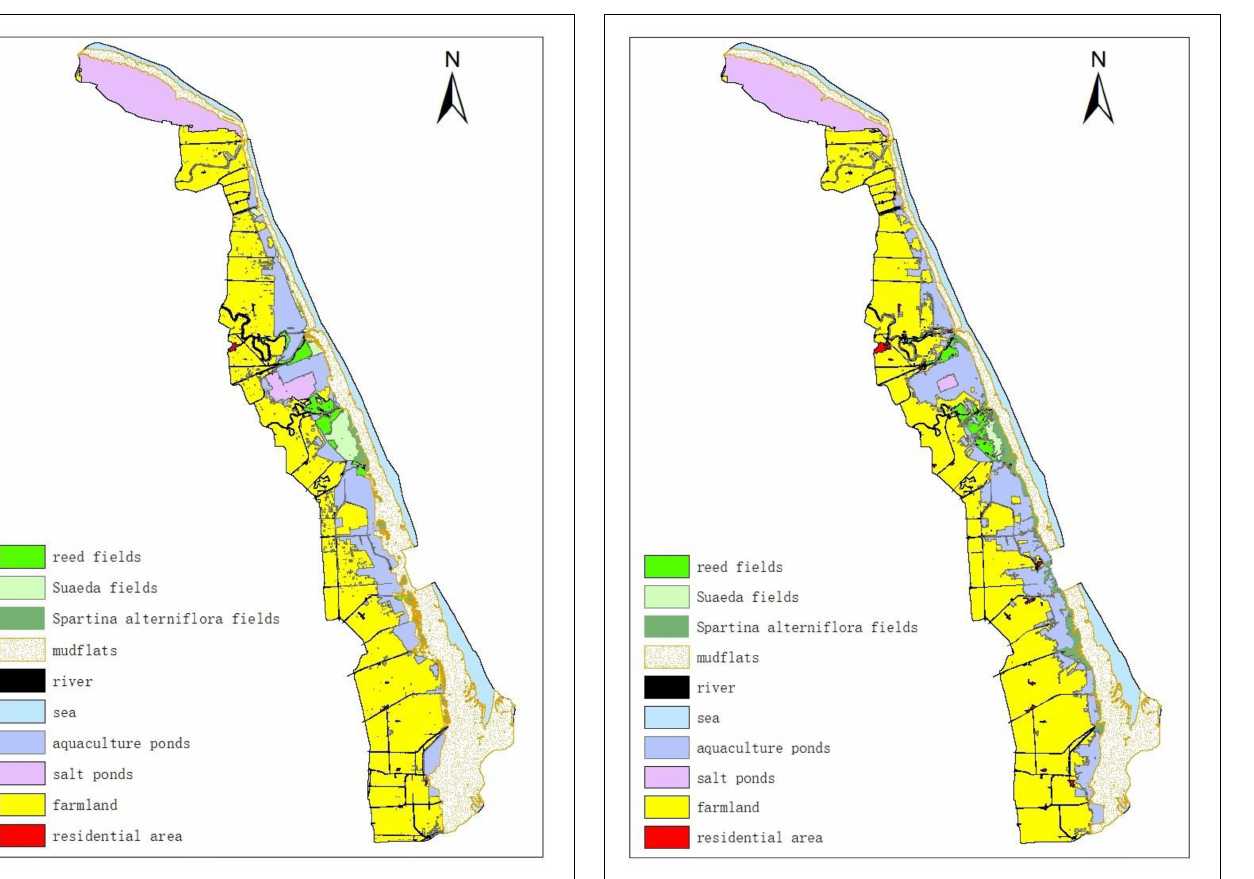
FIGURE 4 | Landscape map of Yancheng coast in 2000. FIGURE 5 | Landscape map of Yancheng coast in